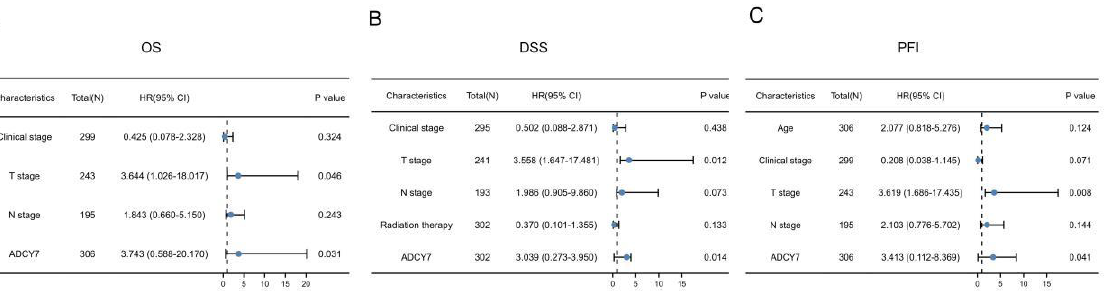
Figure 4. Forest plot of the multivariate Cox regression analysis in cervical cancer. ( A – C ) Risk factors with OS, DSS, and PFI rates of CESC patients with high ADCY7 expression.